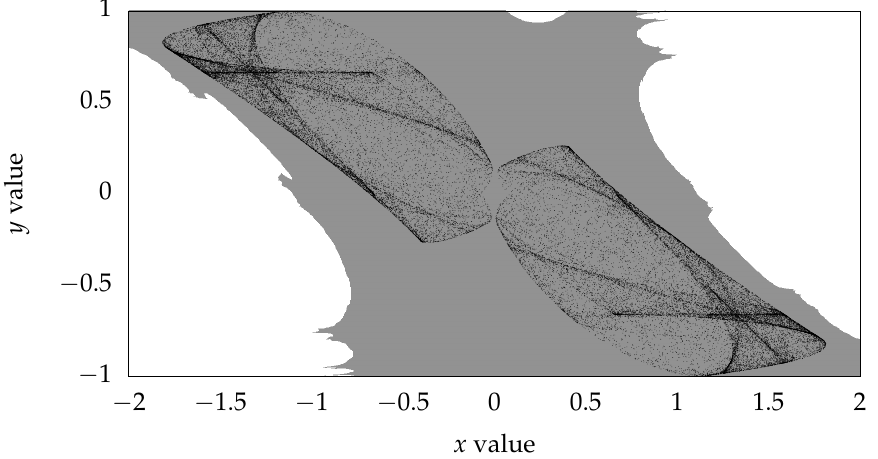
Figure 1. The domain of attraction of the map in Equation (1). This domain was obtained in floating point arithmetic. Moreover, 40,000 points obtained with initial conditions ( x ( 0 ) , y ( 0 )) = ( are shown.